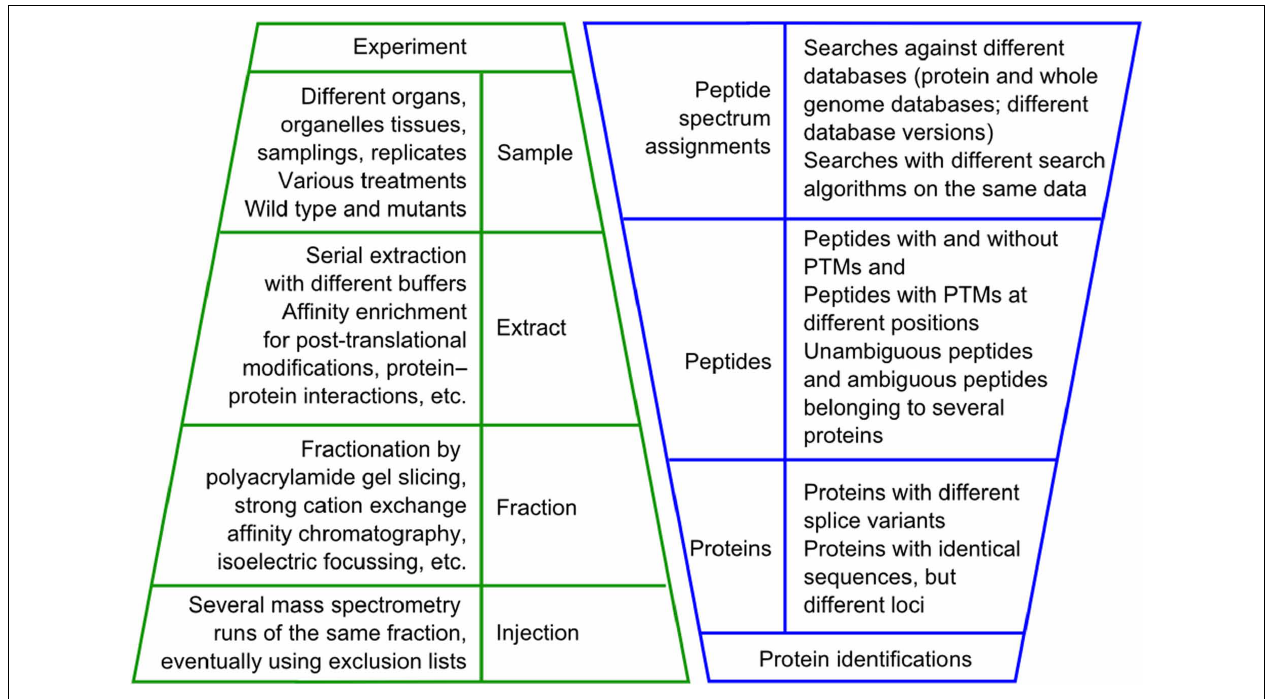
mass spectrometry data are then subjected to one or several database-dependent peptide assignment algorithms. In the search results one to several spectra are assigned to a peptide sequence and one to several peptides are assigned to a protein sequence. PTM, post-translational